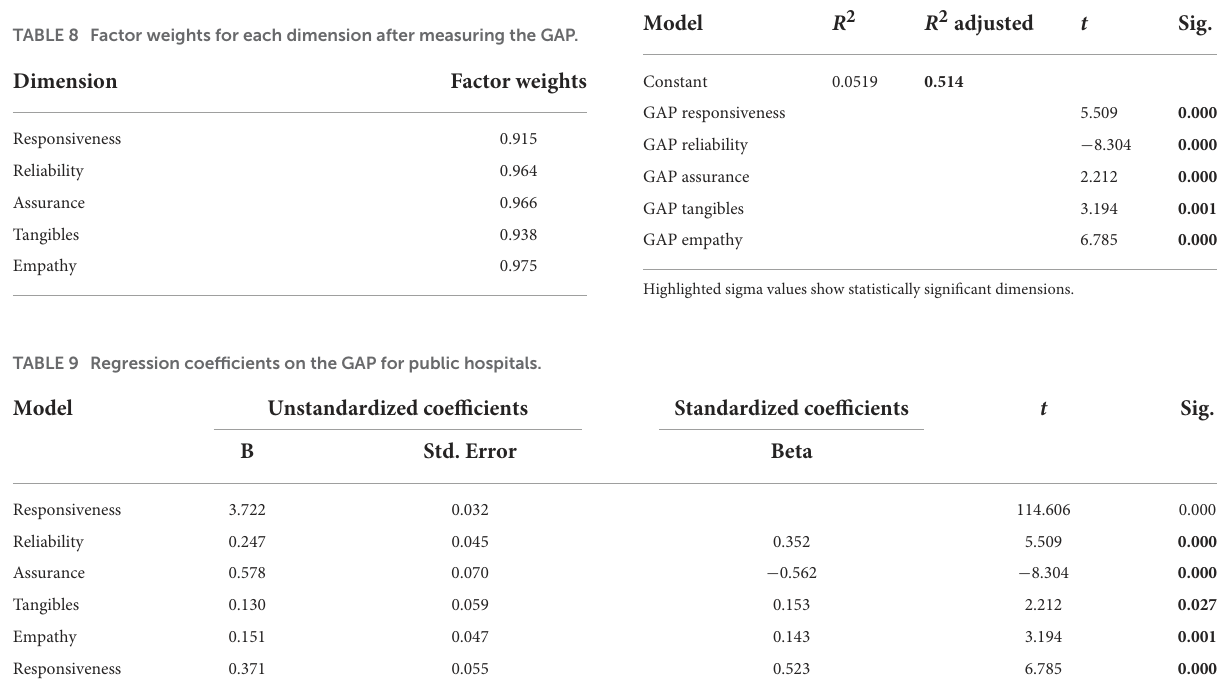
public hospitals.